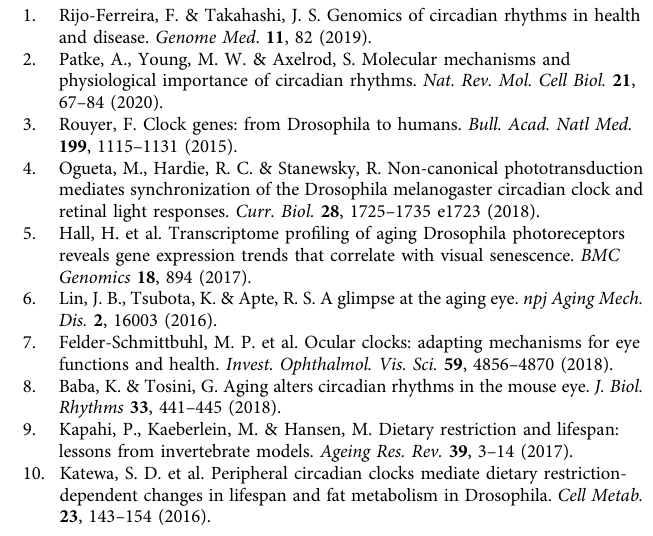
Figure 3c: The number of biologically independent fl ies with similar observable phenotypes to the main fi gure are as follows (Day 2, 10): AL cnt 4, 2 fl ies, AL prCLK- Δ 1 2, 3 fl ies, AL prCLK-OE 2, 2 fl ies, DR cnt 3, 6 fl ies, DR prCLK- Δ 1 3, 1 fl ies, DR prCLK-OE 4, 3 fl ies. Figure 5: The number of fl ies used for lifespan analyses are as follows: (a) LD housed fl ies: AL N = 560, DR N = 584; DD housed fl ies: AL N = 460, DR N = 462. (b-g) w 1118 ; ninaE 17 fl ies: AL N = 514, DR N = 511; w 1118 ; rh3 2 fl ies: AL N = 543, DR N = 597; w 1118 ; rh4 1 fl ies: AL N = 550, DR N = 593; w 1118 ; rh6 G fl ies: AL N = 533, DR N = 563; w 1118 ; Gq α 1 fl ies: AL N = 403, DR N = 400. (h) RNAi control fl ies: AL N = 365, DR N = 351; arr1 -RNAi fl ies: AL N = 333, DR N = 322. (i) Retinal-treated fl ies: AL N = 289, DR N = 236; Vehicle-treated fl ies: AL N = 256, DR N = 126. (j) RNAi control fl ies: AL N = 493, DR N = 490; ATP α RNAi fl ies: AL N = 510, DR N = 535. Survival data is plotted as an average of three independent lifespan